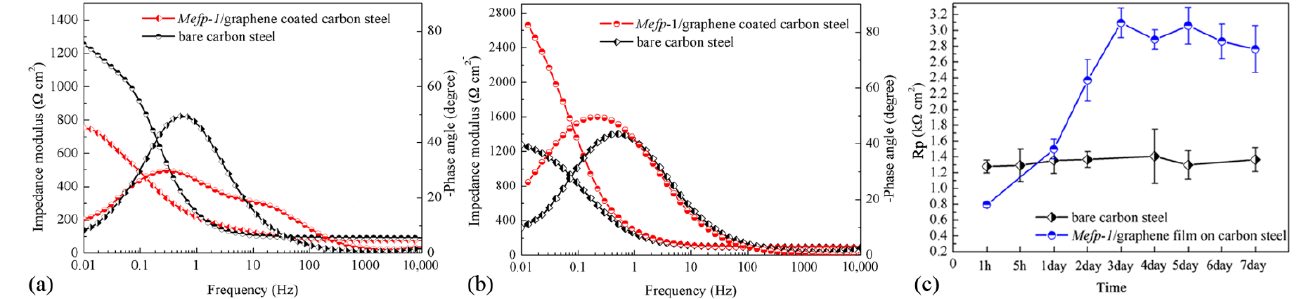
Figure 2. Electrochemical impedance spectrum (EIS) of the composite film on carbon steel prepared by electrophoresis method: ( a ) Bode plots after 1 day exposure; ( b ) bode plots after five day exposure; ( c ) changes of polarization resistance ( Rp ).